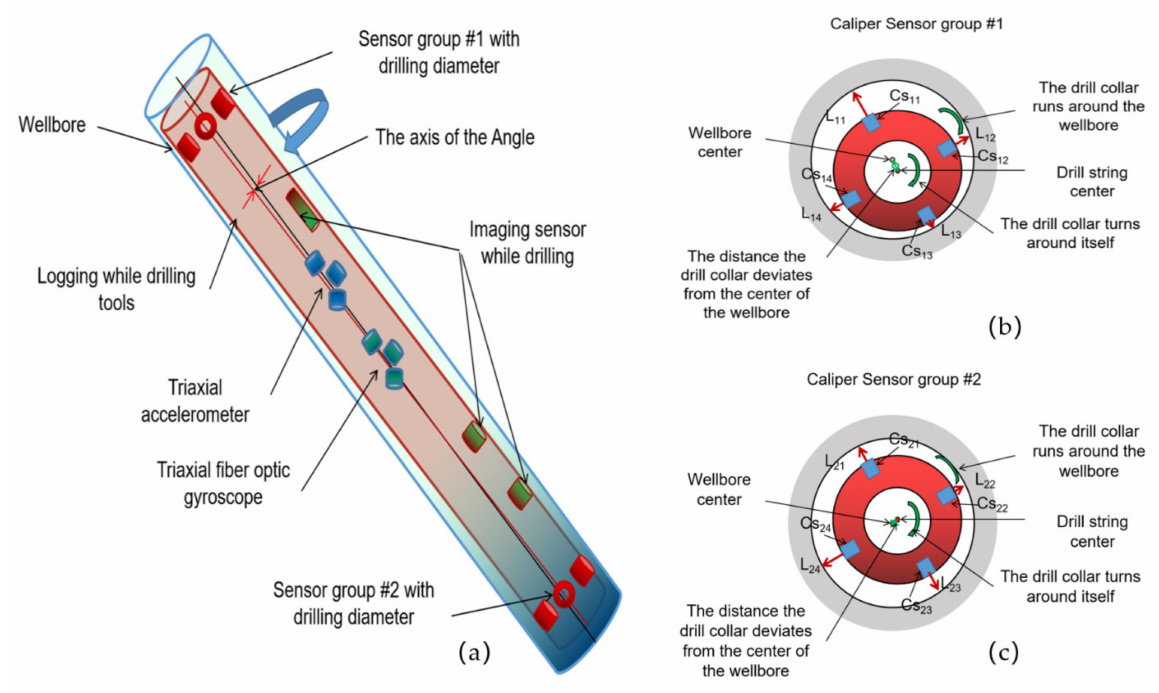
Figure 4. ( a ) Schematic diagram of the multi-sensor layout of the drill string eccentricity measurement system; ( b ) Diagram of upper sensor set eccentricity; ( c ) Diagram of down sensor set